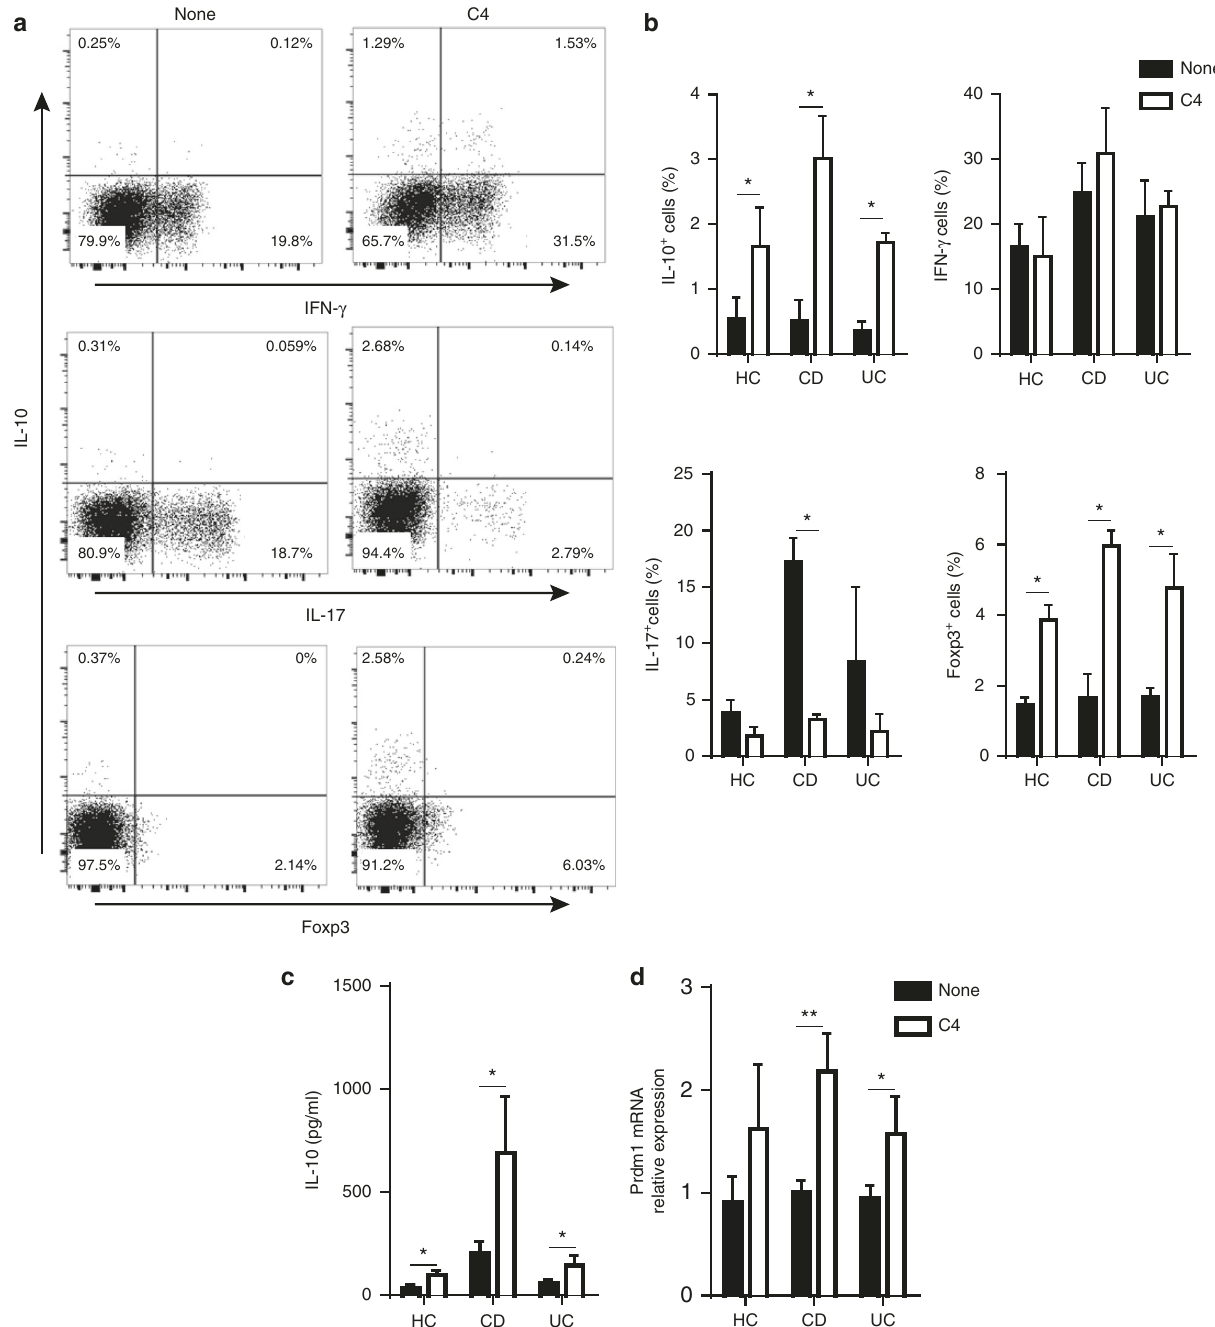
Fig. 8 Butyrate promotes IL-10 production by T-cells from patients with IBD. CD4 + T-cells from peripheral blood mononuclear cells from IBD patients of CD ( n = 6), UC ( n = 6), and healthy individuals (HC, n = 6) were cultured with anti-CD3 mAb and anti-CD28 mAb in the presence of C4 for 5 days. a CD4 + T-cell cytokine production and Foxp3 expression were determined by fl ow cytometry. b Bar charts of the percentage of cytokine-expressing CD4 + T-cells. c IL-10 in supernatants of cell culture and d CD4 + T-cell expression of Prdm1 were examined by ELISA and qRT-PCR, respectively. The results are shown as mean ± SD of triplicates and are representative from one of three experiments performed. * p < 0.05, ** p < 0.01 Student ’ s t